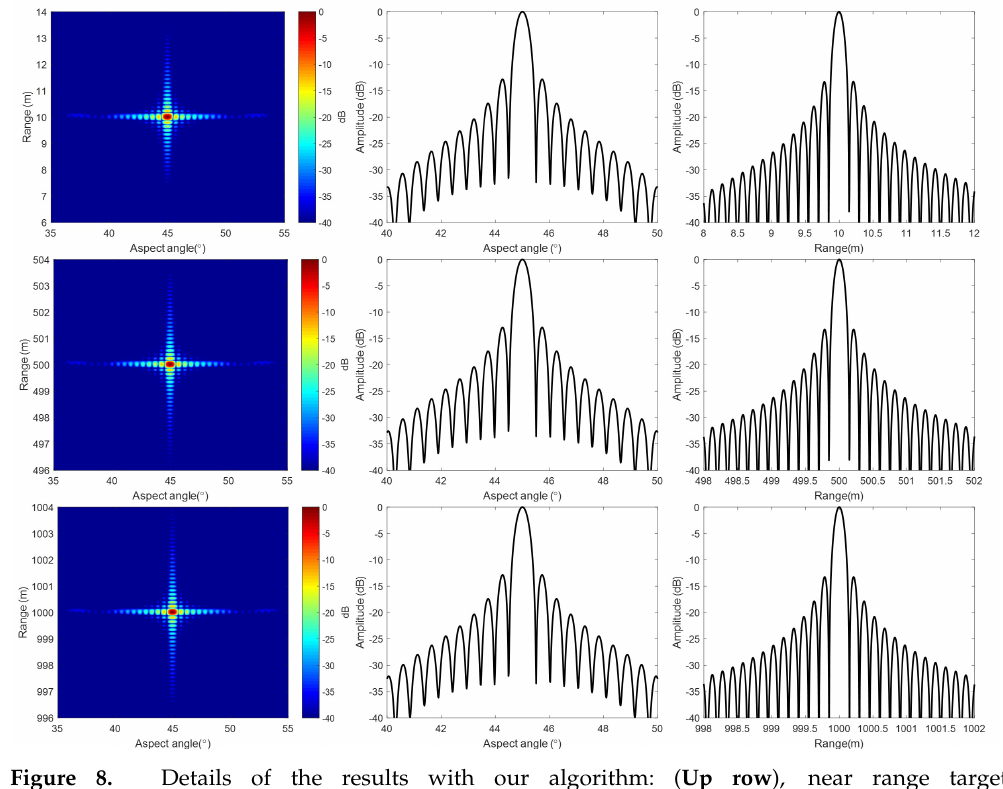
Figure 8. Details of the results with our algorithm: ( Up row ), near range target. ( Middle row ), center range target. ( Bottom row ), far range target. ( Left column ), expended 2-D image. ( Middle column ), azimuth profile through the pulse peak. ( Right column ), range profile through the pulse